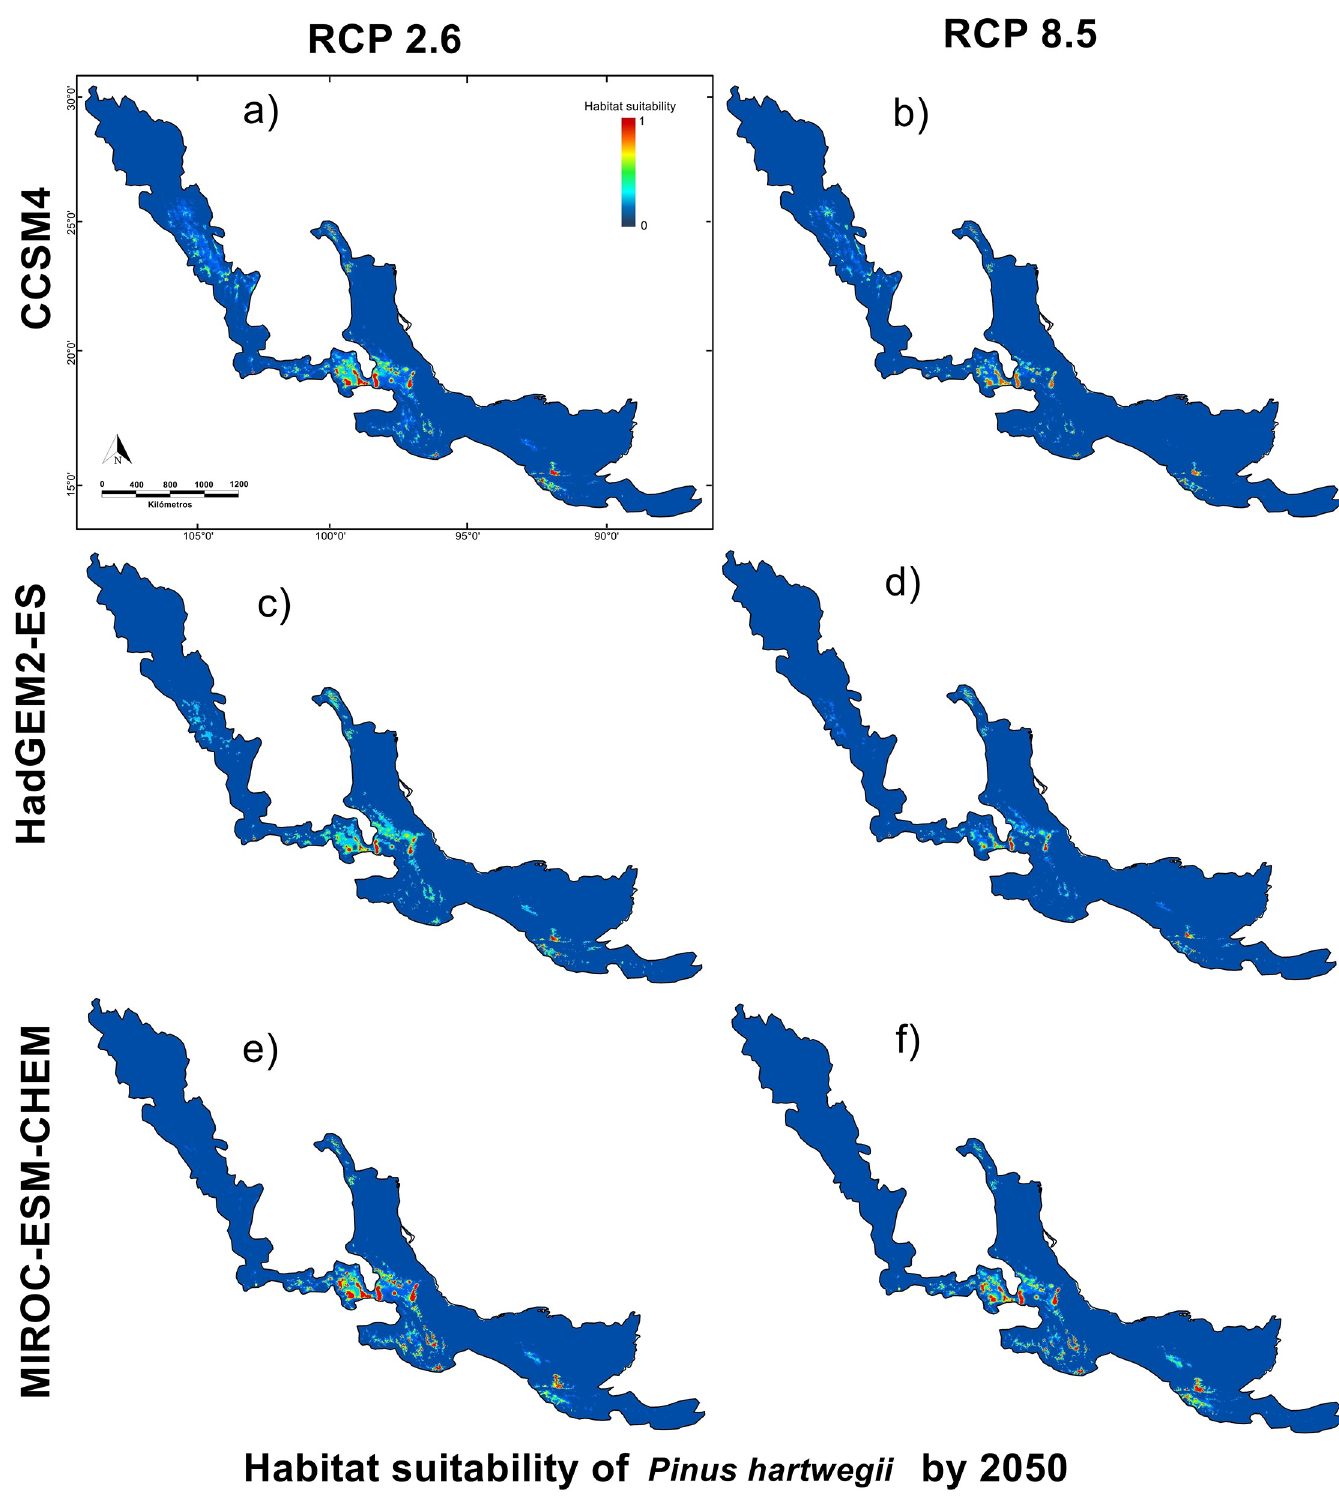
Fig 6. Climate niche model of P . hartwegii for 2050. Models comparing three general circulation models used MIROC-ES-CHEM, CCSM4, and HadGEM2-ES in combination with the two Relative Concentration Pathways used RCP’s 2.6 and 8.5 for the horizon 2050.